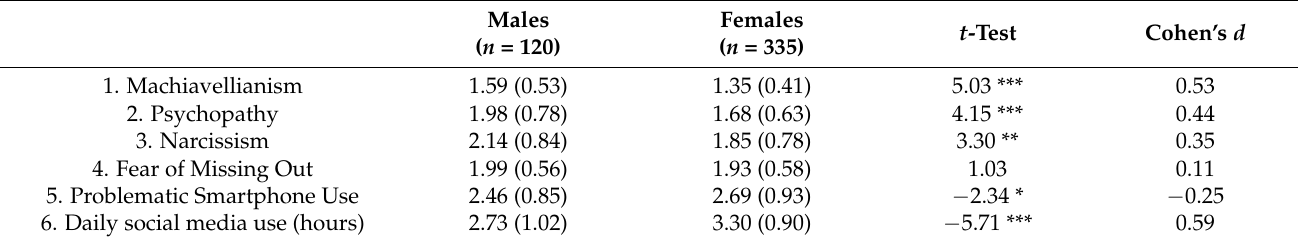
Table 2. Comparison of the total scores of the study variables between males and females.